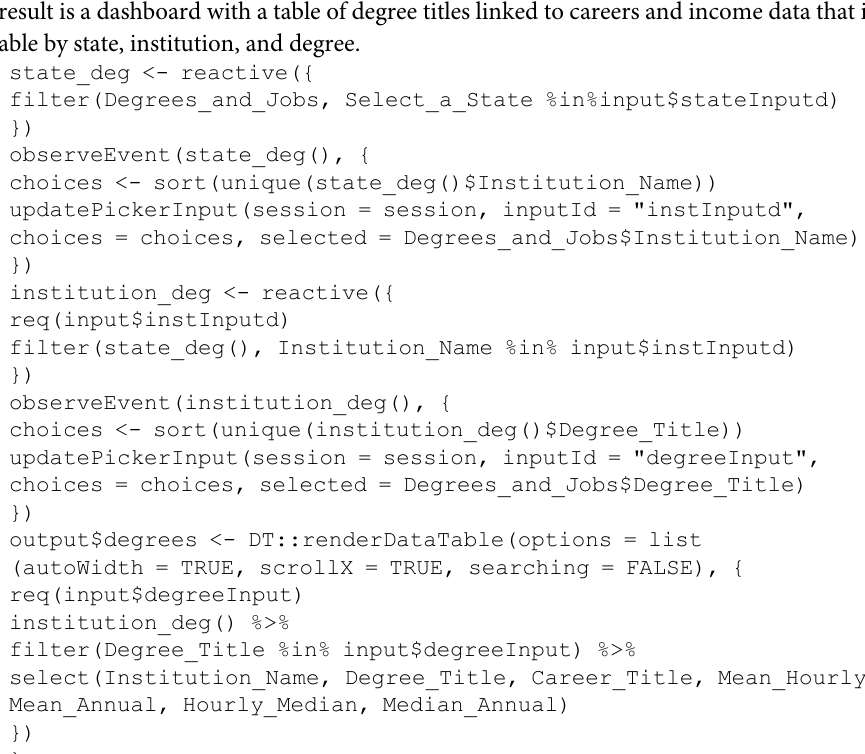
table. The table is rendered as output using the DT :: RenderDataTable() function [36]. The result is a dashboard with a table of degree titles linked to careers and income data that is filter- able by state, institution, and